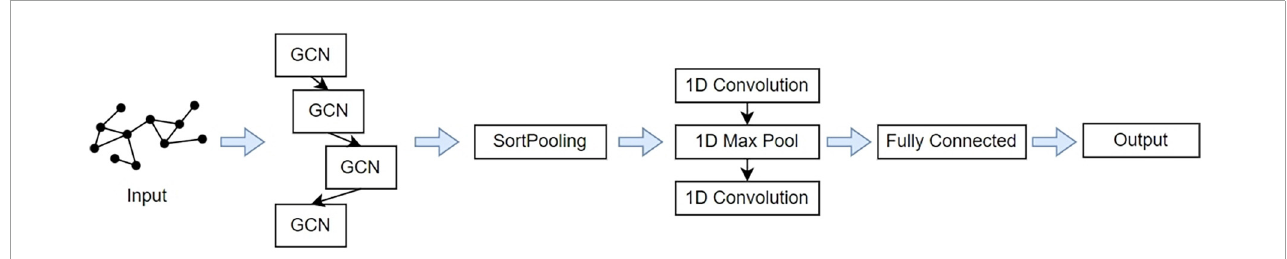
FIGURE3 The overall pipeline of deep graph convolutional neural network (DGCNN) classifier distinguishing between individuals with major depressive disorders (MDD) and normal control